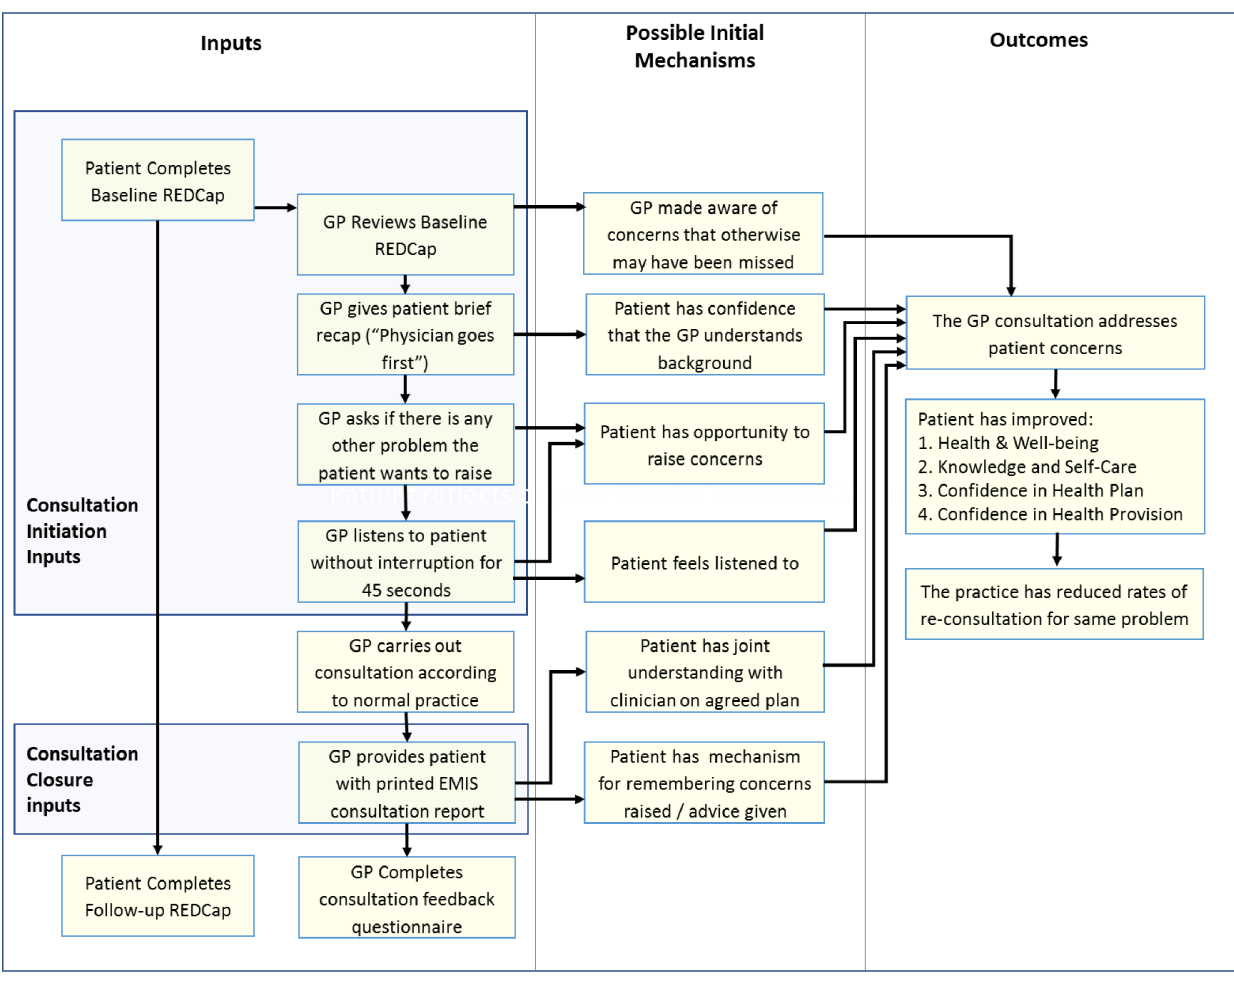
Figure 3. Proposed initial programme theory of